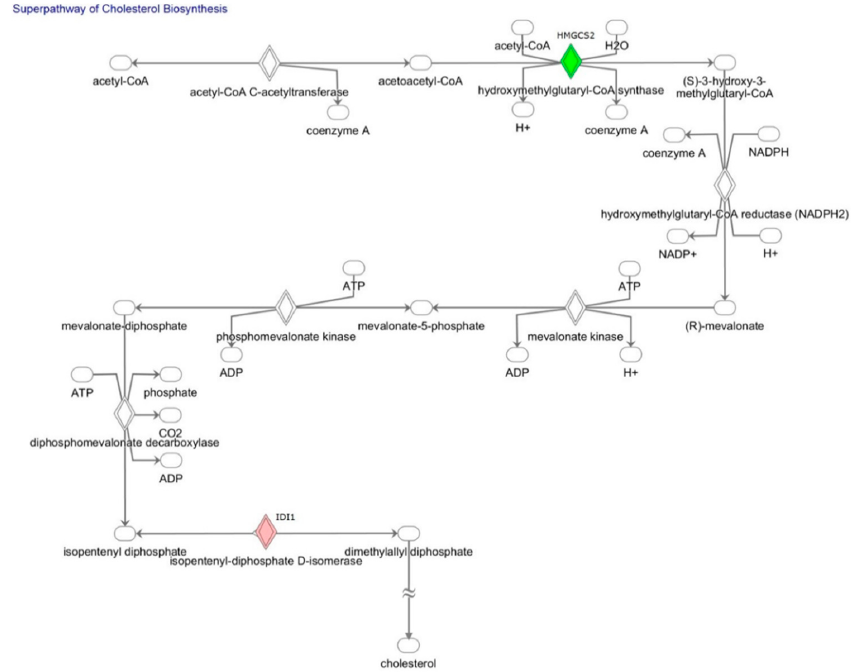
Figure 3. “Superpathway of cholesterol biosynthesis” in the Ingenuity Pathway Analysis. The only genes in the “superpathway of cholesterol biosynthesis” were Idi1 and Hmgcs2 .